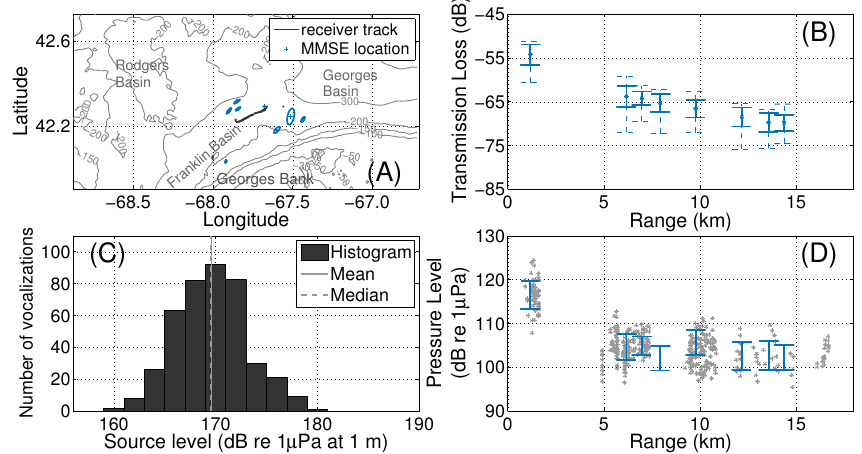
Figure 7. ( A ) The MMSE estimated center locations of sequences of the unidentified baleen whale species downsweep vocalizations from 8 distinct bearing-time trajectories containing a total of 417 vocalizations; ( B ) Corresponding one-way broadband transmission losses from the MMSE estimated unidentified baleen whale species vocalization sequence center locations to the POAWRS receiver array center. The transmission loss standard deviations (solid bar), minimum and maximum values (dotted bar) are calculated assuming the whales are located at each potential depth from the sea surface to near the seafloor; ( C ) The distribution of the unidentified baleen whale species vocalization source level derived from bandpass-filtered beamformed signals has a mean of 169.6 ± 3.5 dB re 1 µ Pa at 1 m; ( D ) The received unidentified baleen whale species vocalization pressure levels estimated from beamformed data plotted as a function of the distance from estimated instantaneous MAT locations of each vocalization to the receiver array center. These data are used to derive the source level distribution shown in ( C ). The blue bars in ( D ) represent one standard deviation in the pressure levels for each bearing-time trajectory.